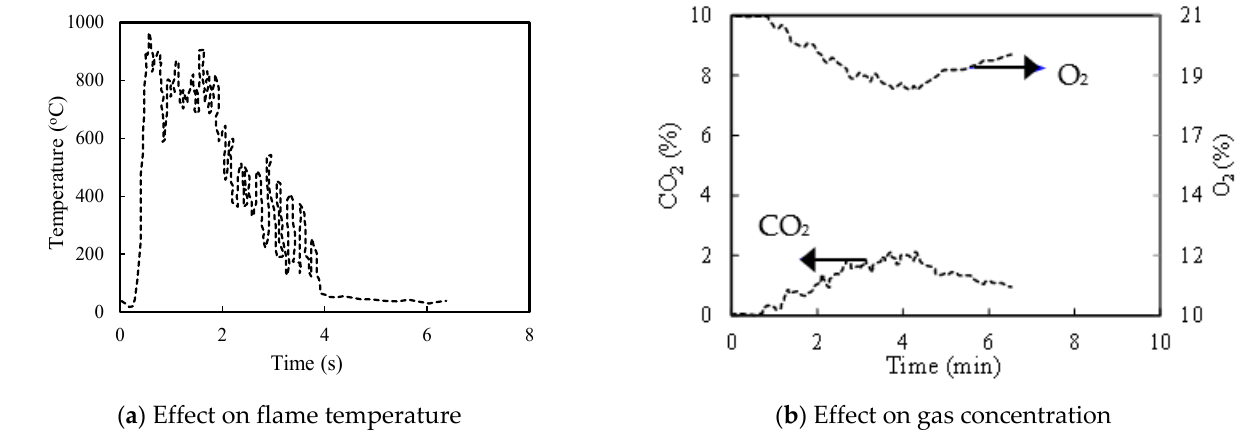
Figure 21. Effect of water mist on a 6 MW diesel-spray fire inside a 940 m 3 compartment [12].